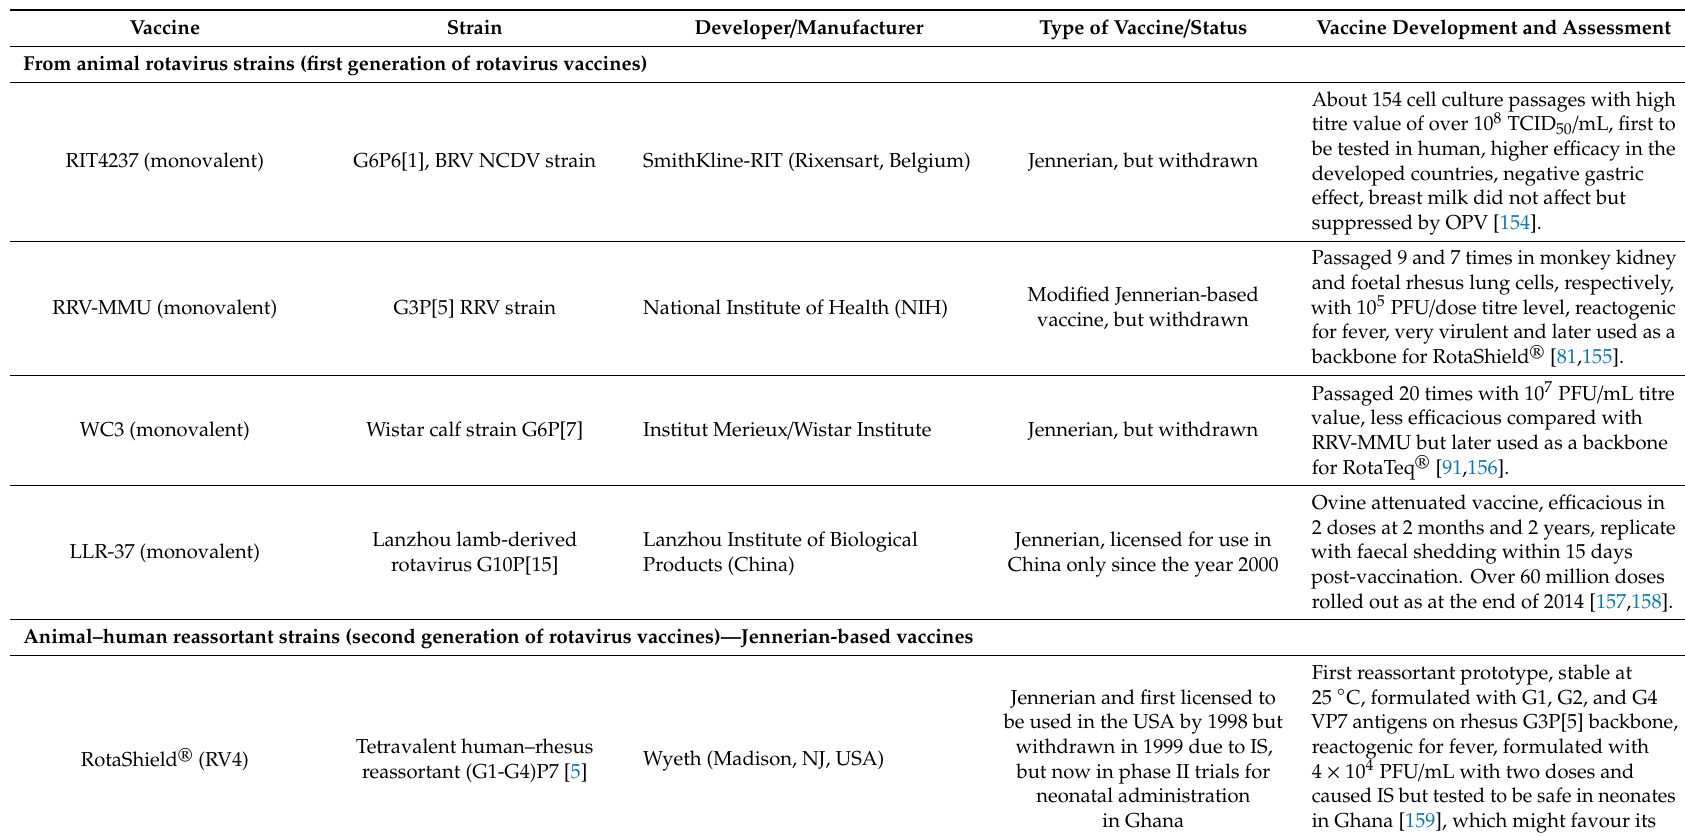
Table 1. Development and pre-clinical assessments of notable live-attenuated oral rotavirus